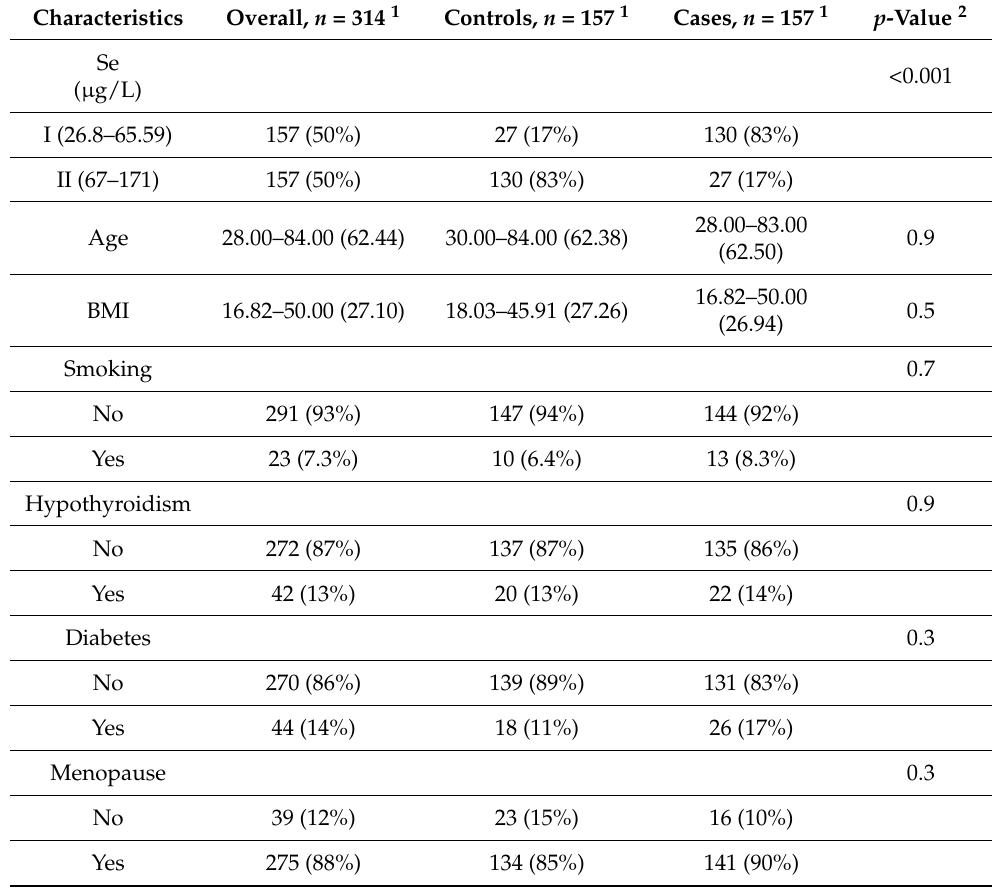
Table 1. Clinical characteristics of patient affected with ovarian cancer and controls included in the study.